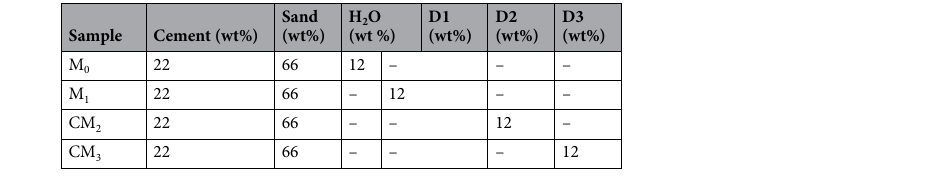
Table 2. Formulations of the manufactured composite